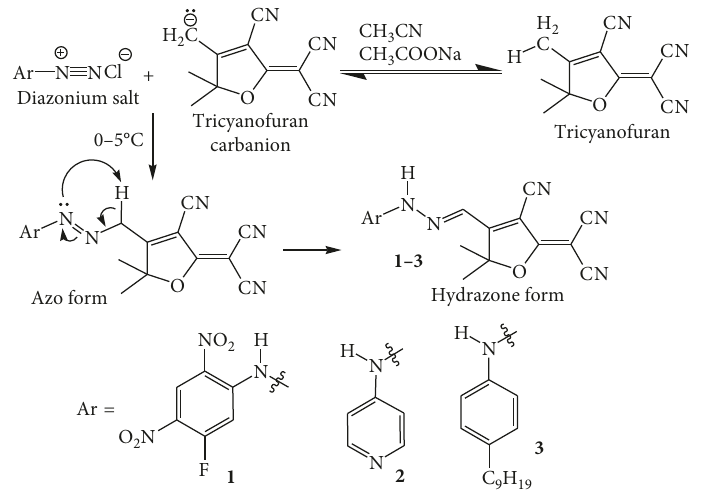
Scheme 1: Synthesis of hydrazone dyes 1 – 3 Table 1: UV-visible absorption maxima of dyestuffs 1 – 3 in dif- ferent solvents.